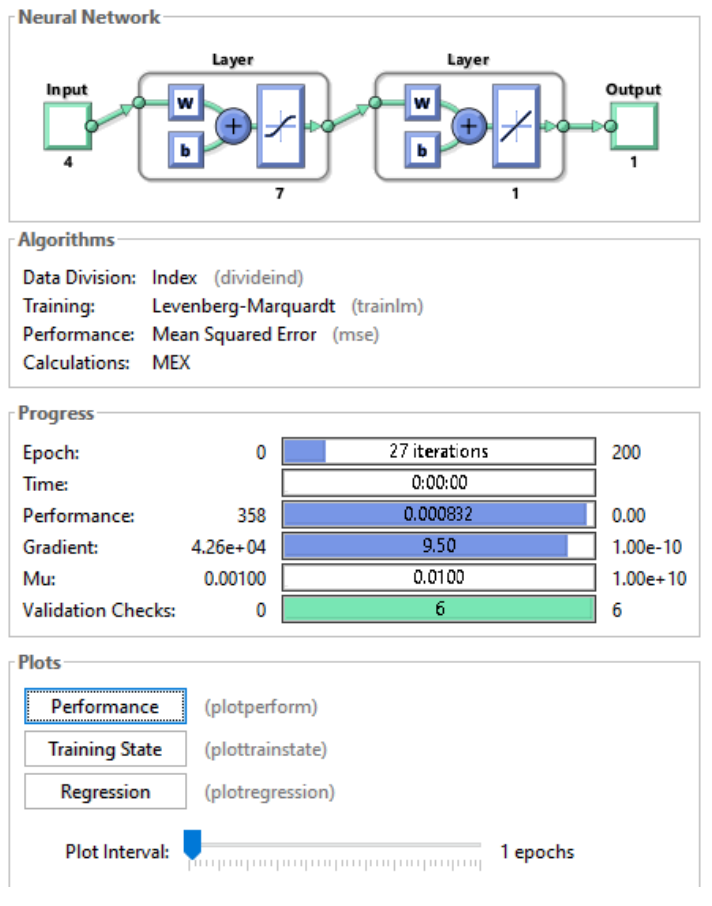
Figure 22. Neural network parameters.